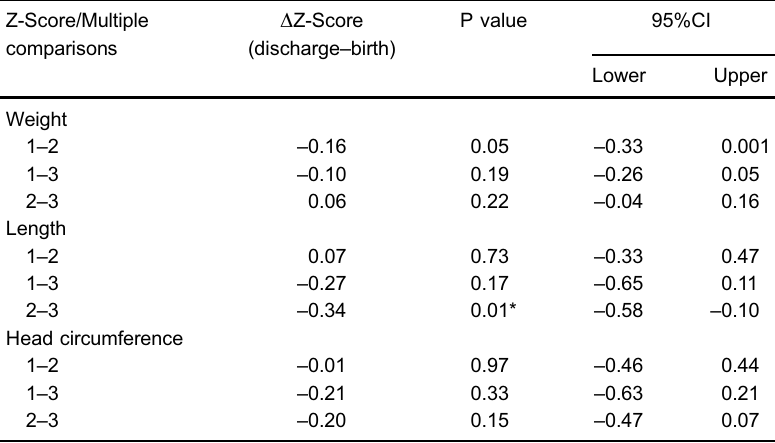
Table 3. Adjusted linear regression model for comparative analysis of mean differences in Z-scores for weight, length and head circumference between discharge and birth for the different study